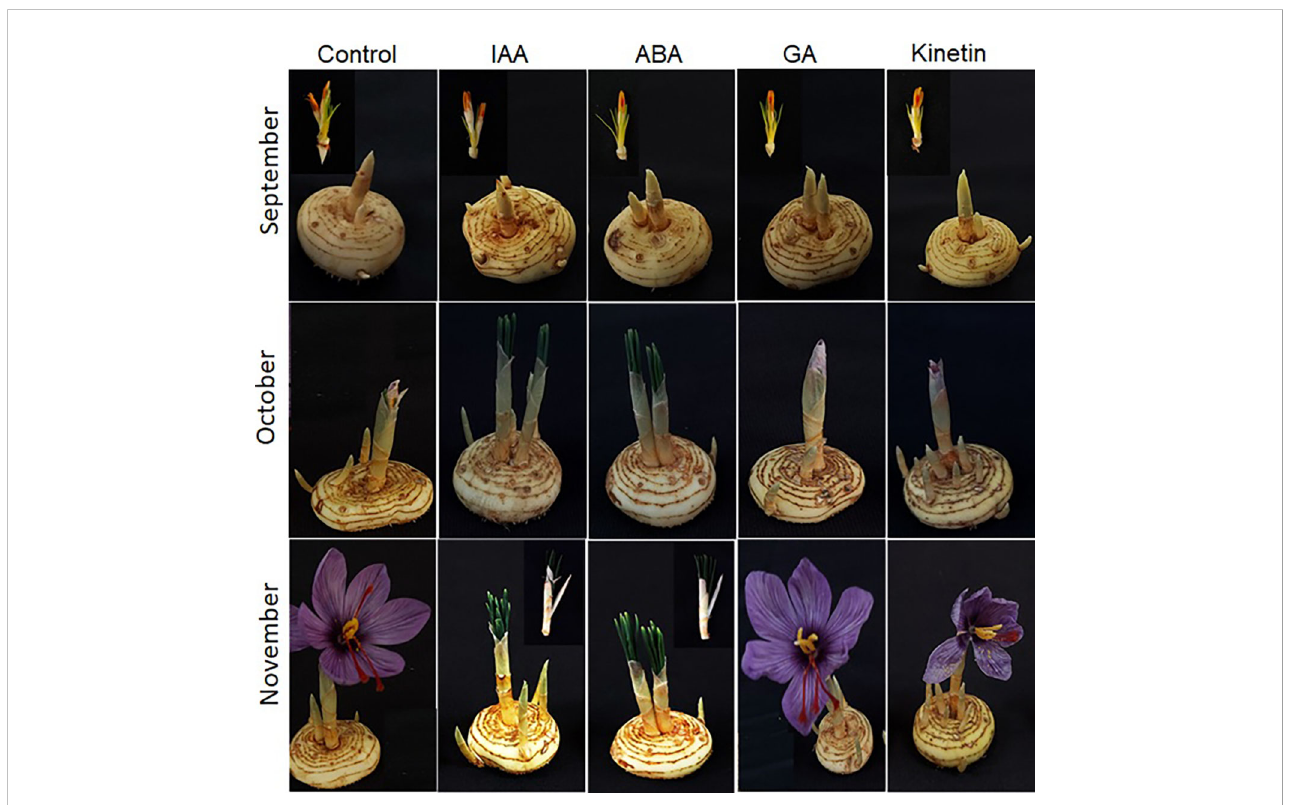
FIGURE 6 Morphological changes during fl ower formation in saffron after hormonal treatments. Corms already fl oral-initiated in early September were treated with different hormones and sampled after 45 days (mid-October) and 90 days (end of